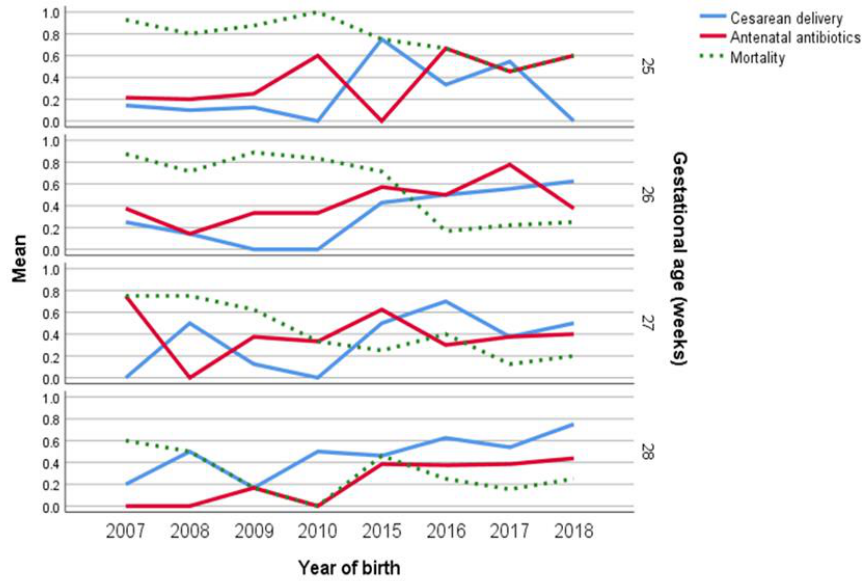
Figure 1. Relation between antenatal interventions and overall mortality among different gestational ages according to the year of birth.